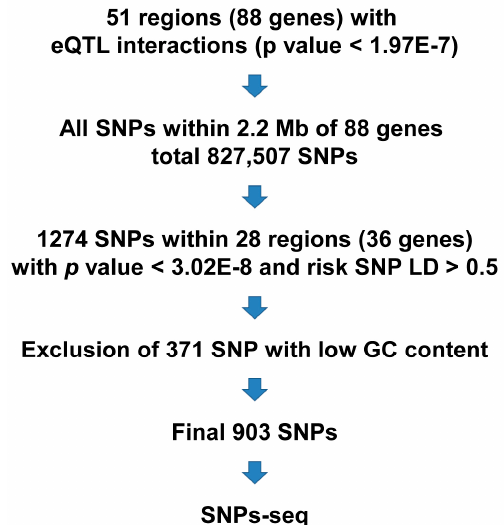
Figure 1. Workflow of candidate single-nucleotide polymorphism (SNP) selection. eQTL: expression quantitative trait